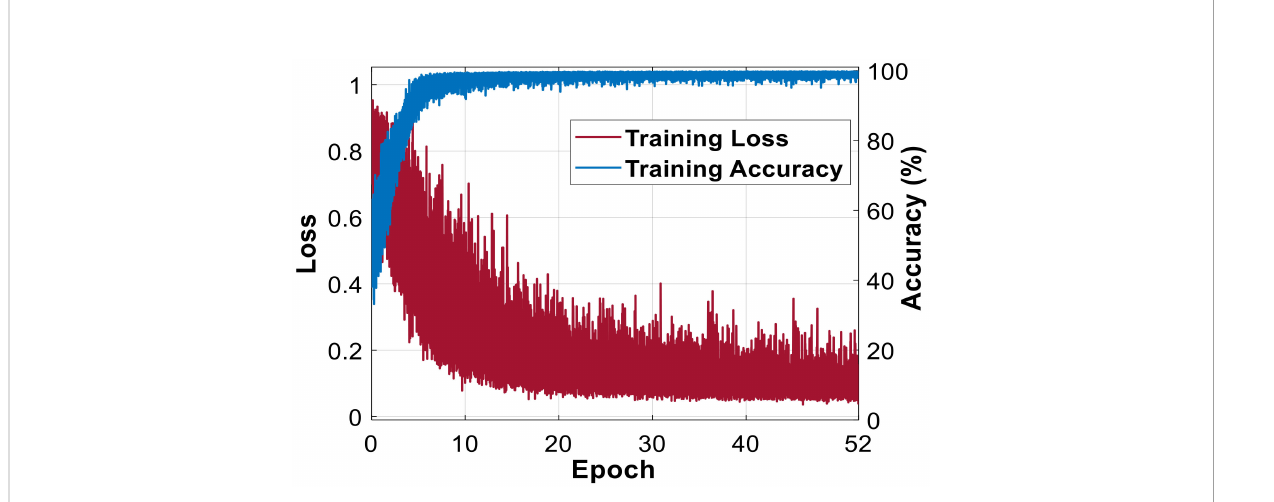
FIGURE 7 Training accuracy and loss